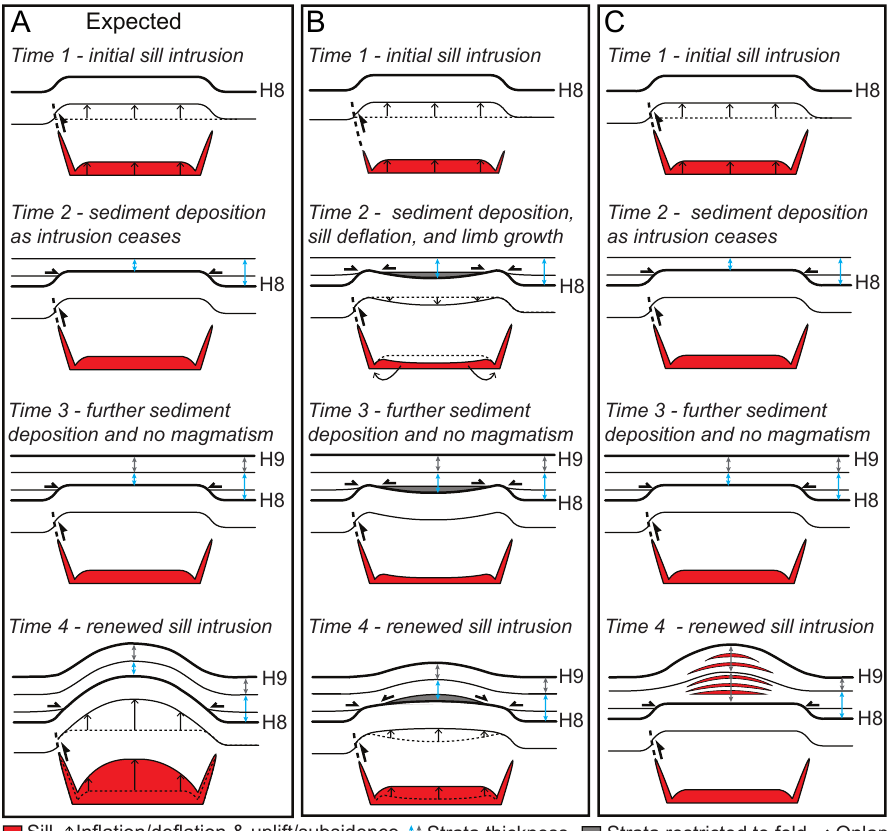
Figure 12: [A] Schematic summarising the expected fold geometry and onlap relationships for forced folds, specif- ically folds 1 and 3. [B] Schematic describing how evacuation of a tabular sill and formation of inclined limbs can drive subsidence across the crest of a forced fold, which can accommodate depositing sediments. Repeated sill inflation/deflation and forced fold uplift/subsidence cycles could produce the observed upward increase in fold amplitude from H8 to H9 and thickening of the H8–H9 strata across the fold. [C] Schematic showing how the occurrence of seismically undetected, thin sills within the fold could produce the observed upward increase in fold amplitude from H8 to H9 and thickening of the H8–H9 strata across the fold. All figure parts are drawn to the same relative scale, such that di ff erences in deformation style between the models can be compared. Also note that although the schematics only depict one main sill, which grows through injection of new magma, it is plausible that the actual imaged intrusions consist of multiple accreted sills [e.g. Annen 2011]. fold amplitude of 59 m at H8 to 120 m at H9.